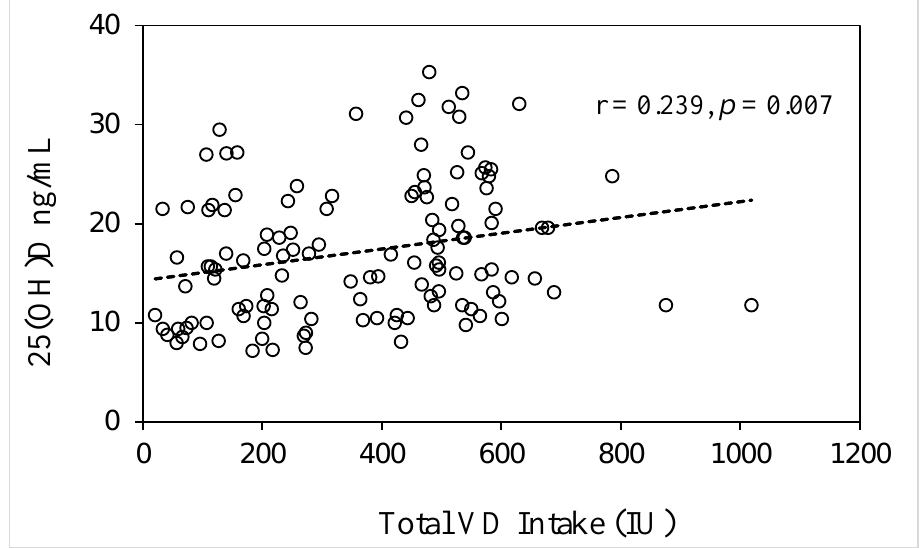
Figure 2. Correlation between serum 25(OH)D level and total VD intake ( n = 125).